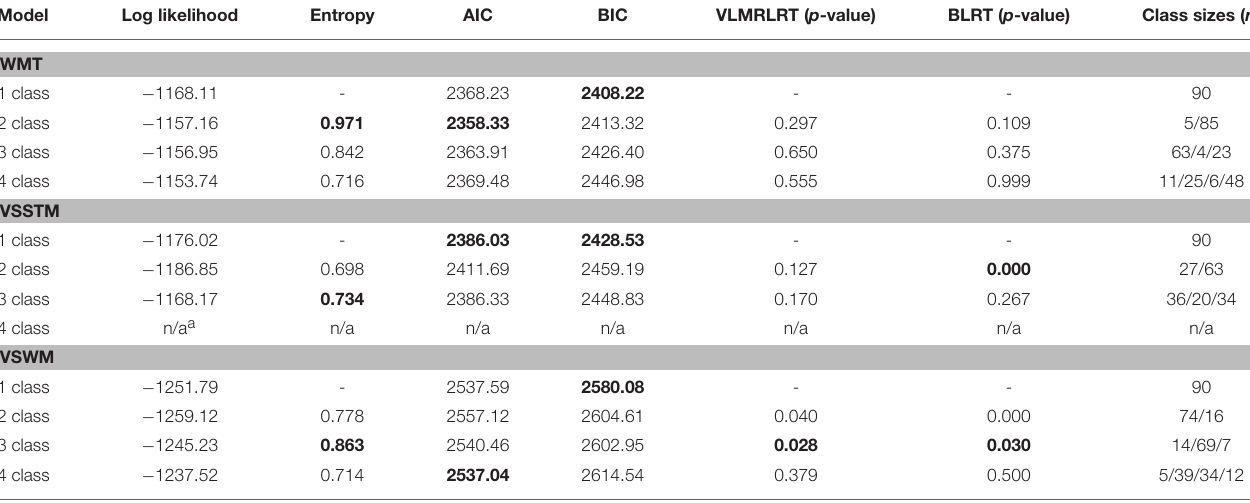
TABLE 4 | Fit indices for GMM models based performance for WM tasks for the typically developing and clinical intervention groups over 8 blocks (with including 5 sessions) for all tasks combined (WMT) and for visuospatial short term memory (VSSTM) and visuospatial working memory tasks (VSWM) separately ( N = 90).